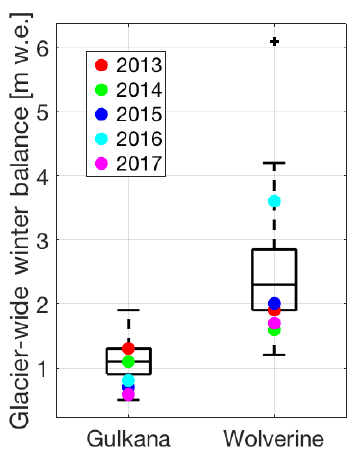
Figure 2. Box plots of glacier-wide winter balance for Gulkana and Wolverine glaciers between 1966 and 2017. Years corresponding to GPR surveys are shown with colored markers. These values have not been adjusted by the geodetic calibration (see O’Neel et al.,